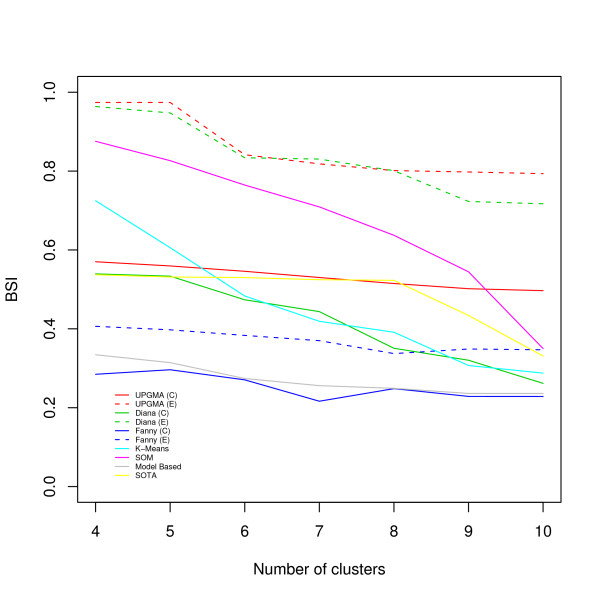
BSI for various clustering algorithms applied to the normal and DCIS samples in breast cancer data.